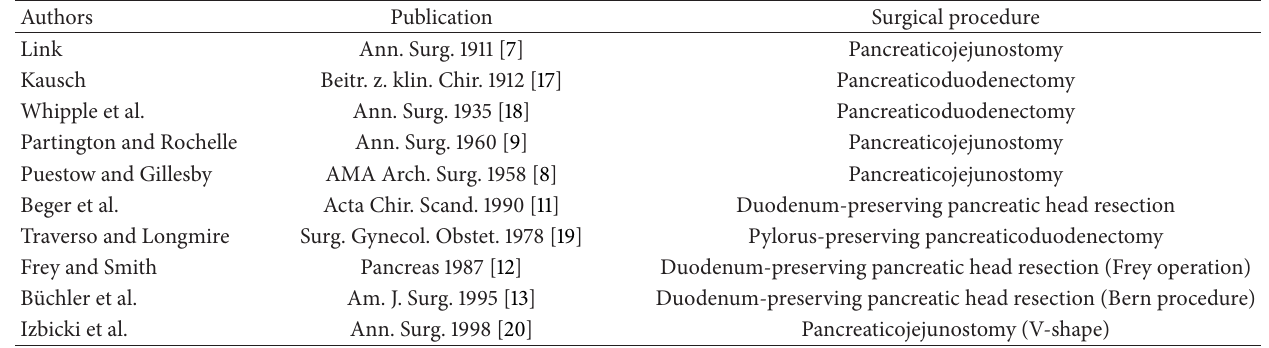
Table 1: Surgical techniques for the treatment of